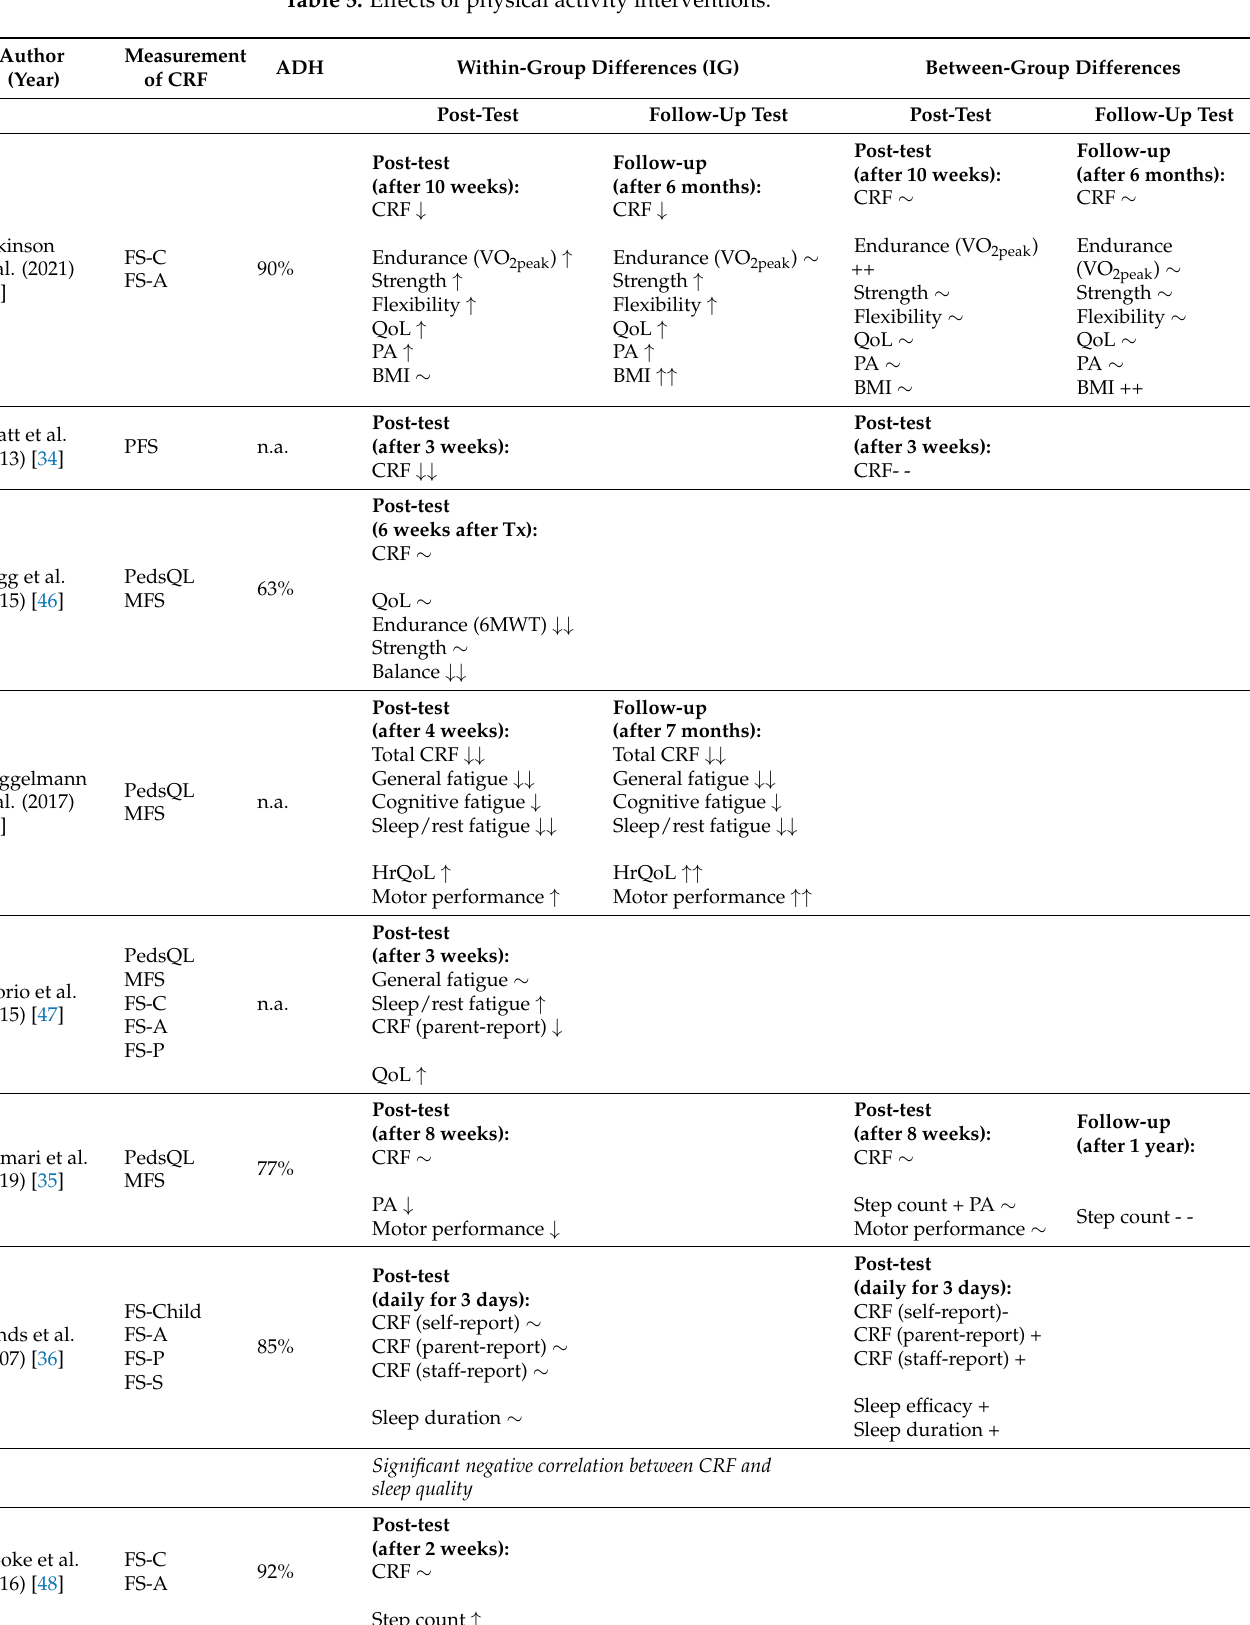
Table 5. Effects of physical activity